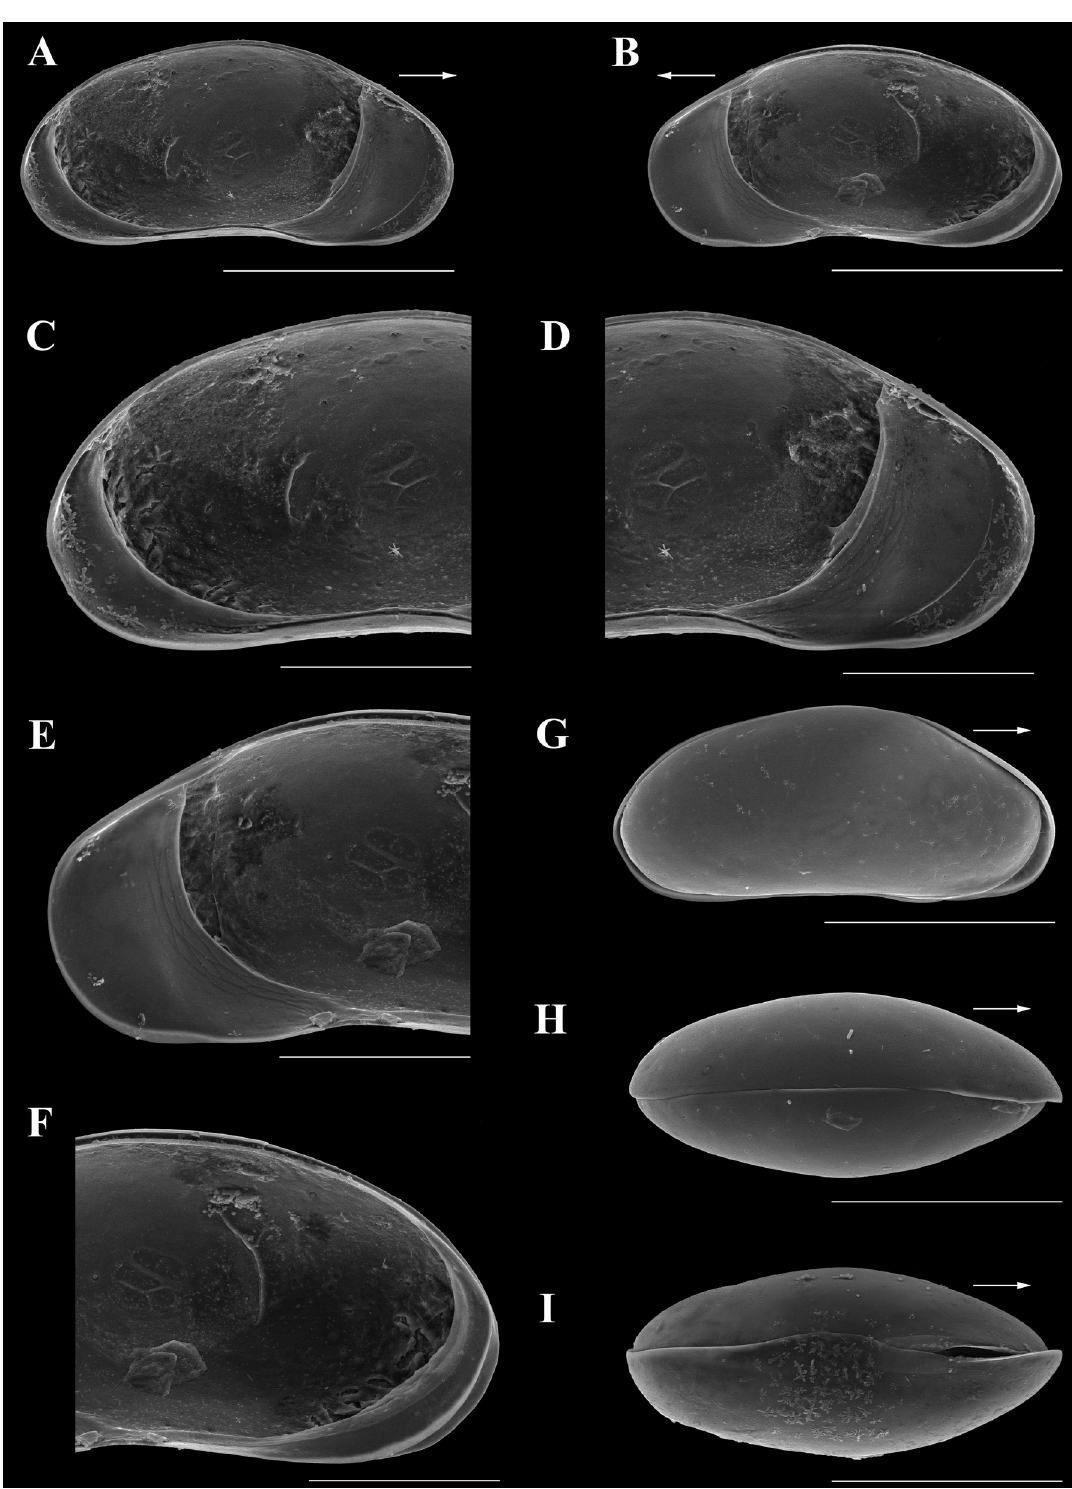
Fig. 18. Paranadopsis reducta gen. et sp. nov. from the Upper Paraná River floodplain, ♀. A . LVi (MZUSP 41872). B . RVi (MZUSP 41872). C . LVi, detail of posterior part (MZUSP 41872). D . LVi, detail of anterior part (MZUSP 41872). E . RVi, detail of anterior part (MZUSP 41872). F . RVi, detail of posterior part (MZUSP 41872). G . CpRl (MZUSP 41873). H . CpD (MZUSP 41874). I . CpV (JH490). Scale bars: A–B, G–I = 200 µm; C–F = 100